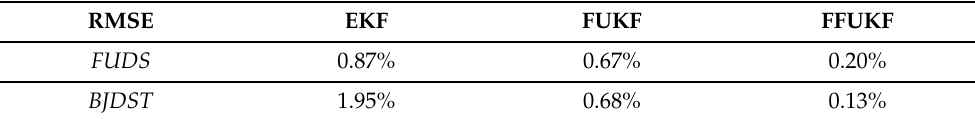
Table 3. The RMSE under BJDST and FUDS at 25 ◦ C.